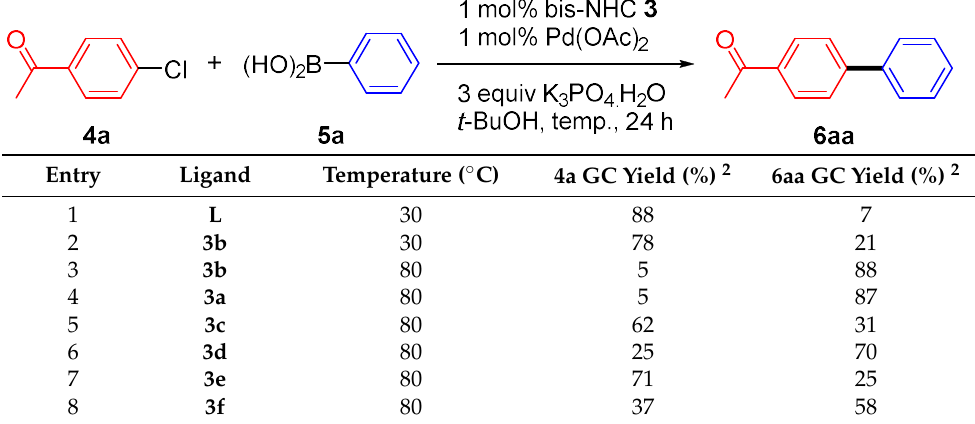
Table 1. Screening the activity of the in-situ-formed bis-NHC/Pd catalyst 1 .